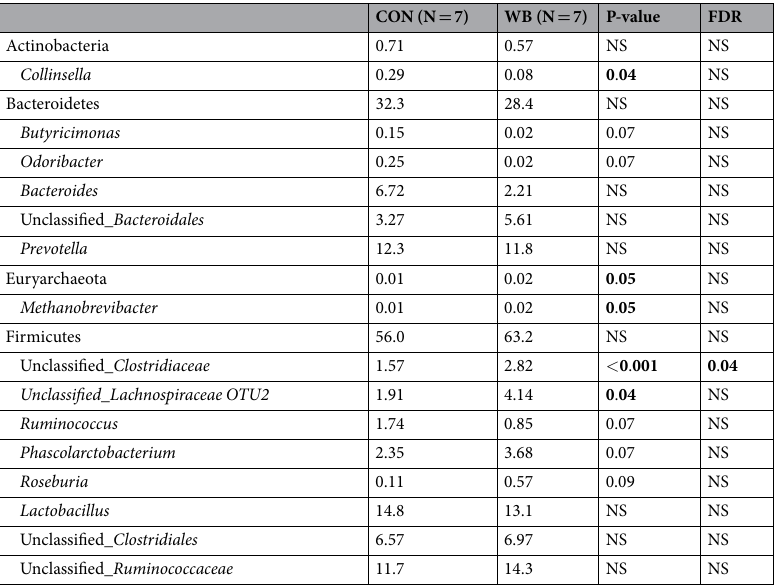
Table 3. Relative abundance of bacterial genera sampled in the colon of piglets born from sows fed the control diet (CON) and the wheat bran-enriched diet (WB), only genera with abundance > 0.01% are displayed in this table. P-values and FDR are considered as significant < 0.05 and numerically different with a value <